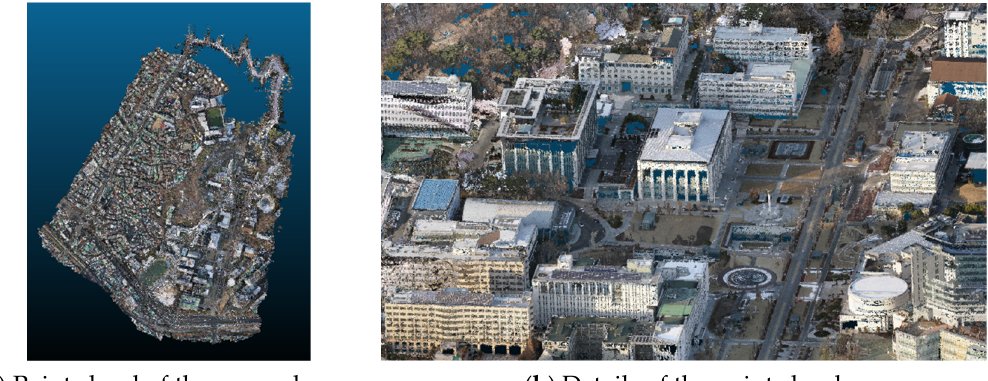
Figure 5. Hybrid point cloud for GCPs.